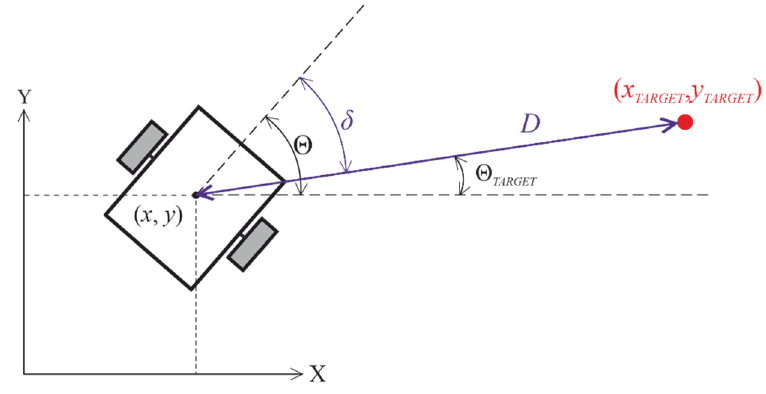
Figure 2. Meaning of input quantities to EN20 mobile robot fuzzy controller.